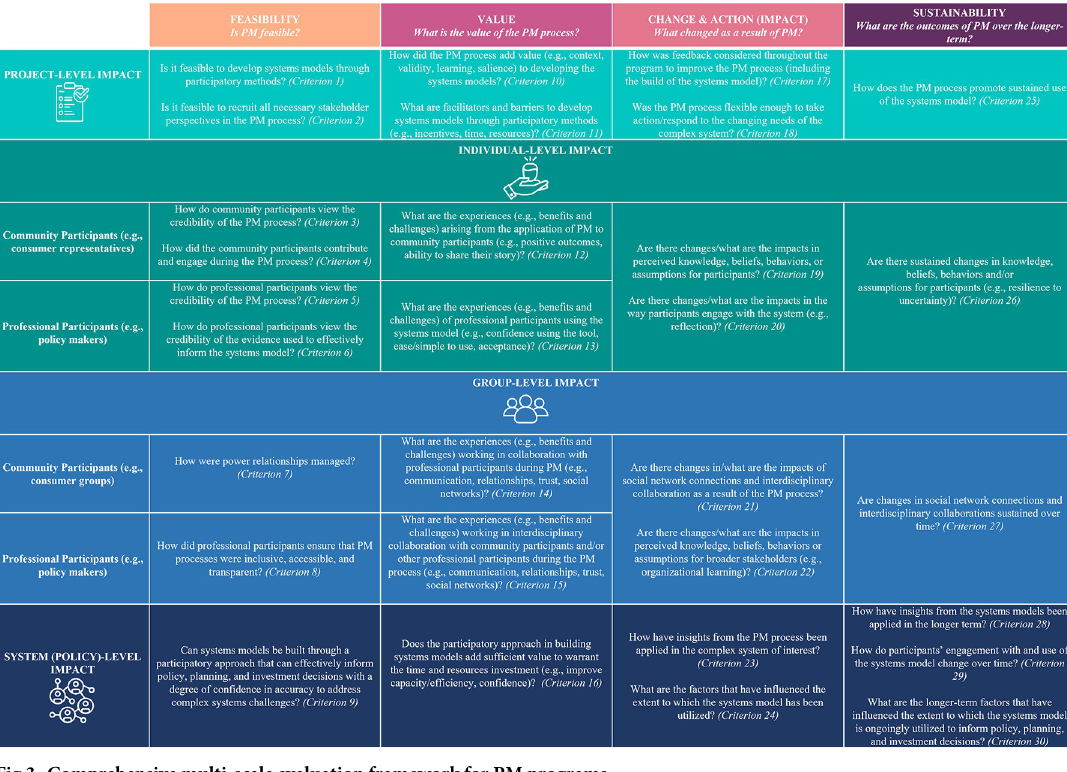
Fig 3. Comprehensive multi-scale evaluation framework for PM